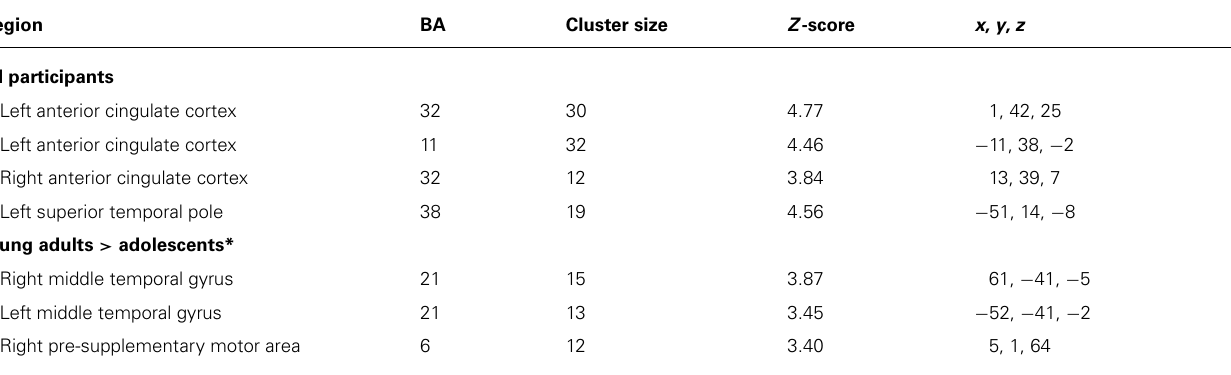
Table 2 | Significant clusters of activation in the whole-brain analysis for the contrast Dangerous choice > Safechoice ( N = 60) and by age groups (FWE, corrected, p ≤ 0.0001; except contrasts marked with symbol “*” that employed an uncorrected threshold of p ≤ 0.0001; extent threshold > 10